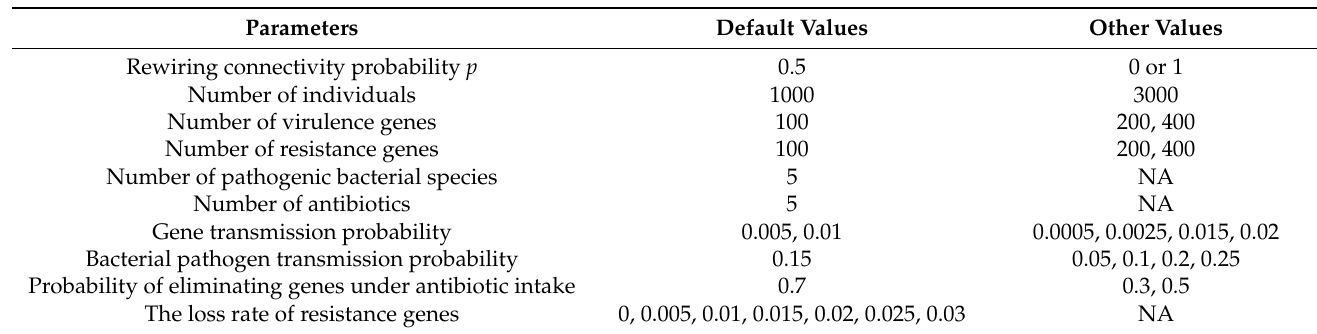
Figure 2. Flowchart of the program. After the network’s construction, the program performs several cycles where, eventually, there is gene transfer between nodes (people). Some individuals get sick and take antibiotics. Some genes are lost due to antibiotic pressure or the fitness cost imposed by resistance genes. Table 2. Parameters and default values used in